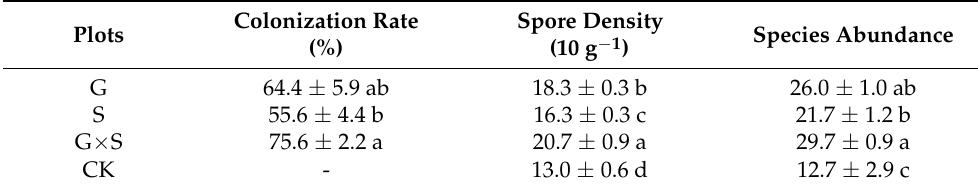
Table 3. Differences of AMF colonization rate, spore density, and species abundance among different vegetation types. Plots